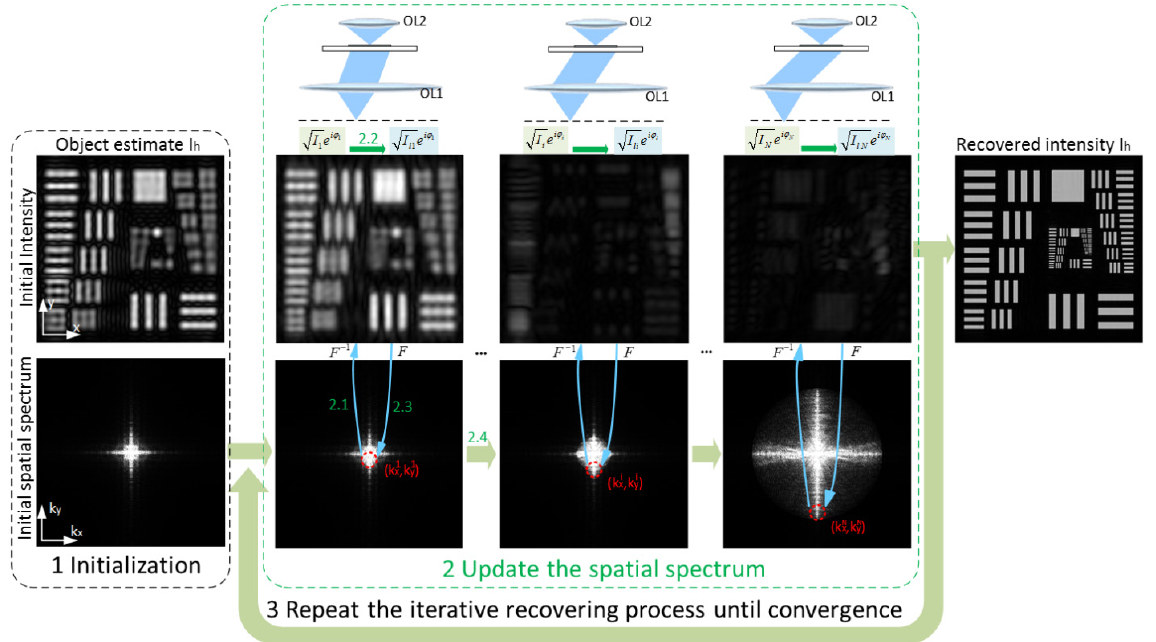
Fig. 3. Flow chart of FPM's algorithm. A high-resolution intensity image is recovered by using N low-resolution intensity images I – 3 illustrate the iterative recovering process of FPM. Step 1: li which are obtained under variable incidence of illumination. Steps 1 initialize the object estimate I h . Step 2.1: select a subregion of the initial spatial spectrum and perform inverse Fourier transform to ffiffiffiffiffi p I I e i ’ 1 . Step 2.2: replace I generate a low-resolution image ffiffiffiffiffiffi p l 1 . Step 2.3: update the corresponding 1 1 by the recorded image intensity I e i ’ 1 in frequency domain (the region encircled by the red circle). Step 2.4: repeat steps 2.1 – 2.3 for other plane-wave subregion of l 1